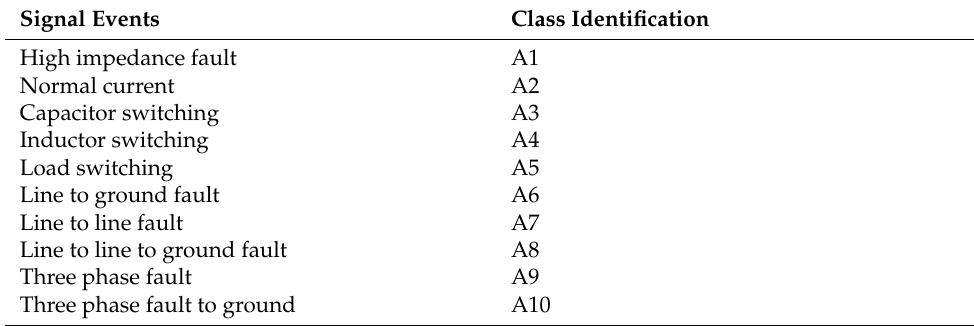
Table 6. Description of different signal events.